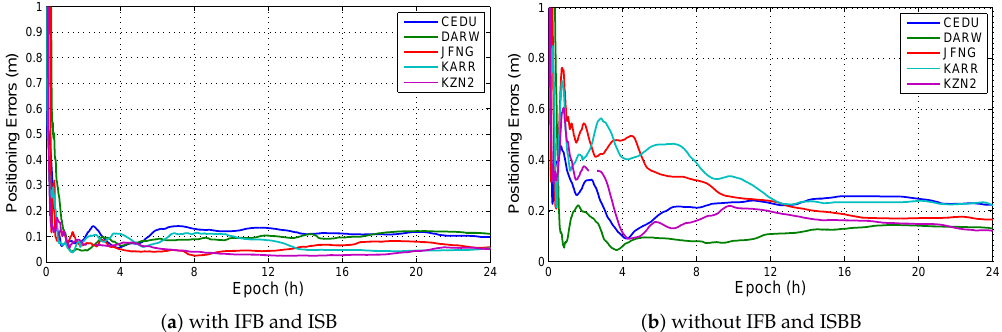
Figure 7. Positioning errors with or without IFB and ISB in UC3-C at different stations. ( a ) The positioning errors in UC3-C with IFB and ISB; ( b ) The positioning errors in UC3-BDS without IFB and ISB.